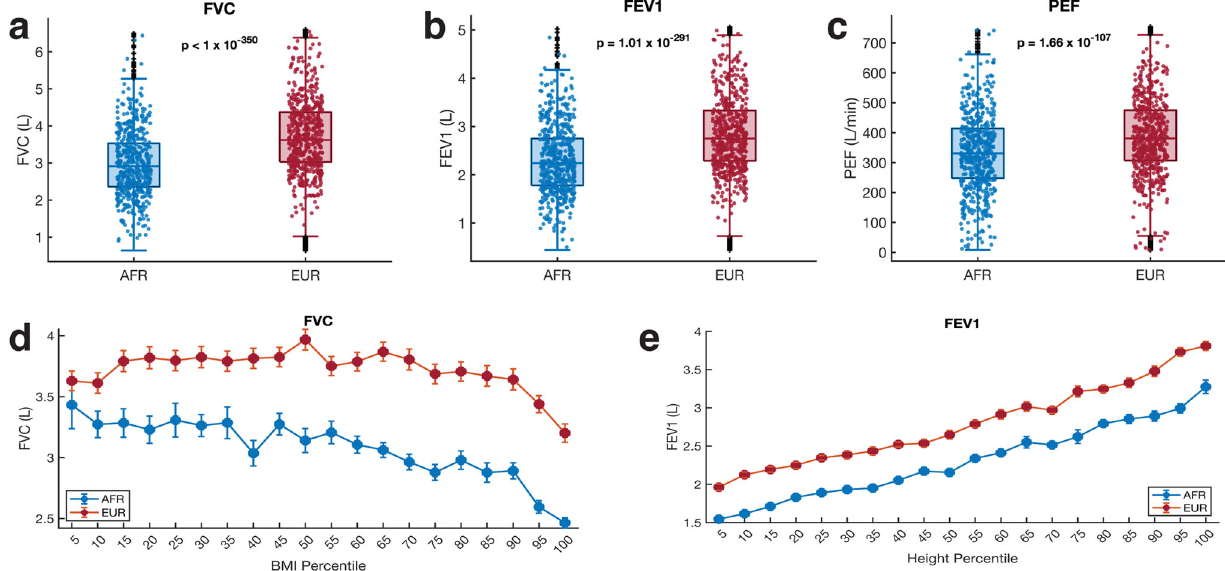
Fig. 1 Comparison of the pulmonary function parameter among Africans and Europeans. The boxplots indicate the distribution of ( a ) FEV1, ( b ) FVC, and ( c ) PEF in Europeans ( n = 383,471) and Africans ( n = 5978). The p -values shown for each comparison were calculated from Welch ’ s t -test. On each box, the central mark indicates the median, and the left and right edges of the box indicate the 25th and 75th percentiles, respectively. The whiskers extend to the most extreme data points not considered outliers, and the outliers are plotted individually using the ‘ + ‘ symbol. To make the visualisation clearer, the fi lled circle mark showing the distribution only includes 1000 randomly sampled points from the total sample size of each group. Error bars showing the variation in ( d ) FVC and ( e ) FEV1 across BMI percentiles and height, respectively, among Africans and Europeans. The middle point indicates the mean FVC or FEV1/FVC, and the error bars indicate the standard error of the mean at the BMI